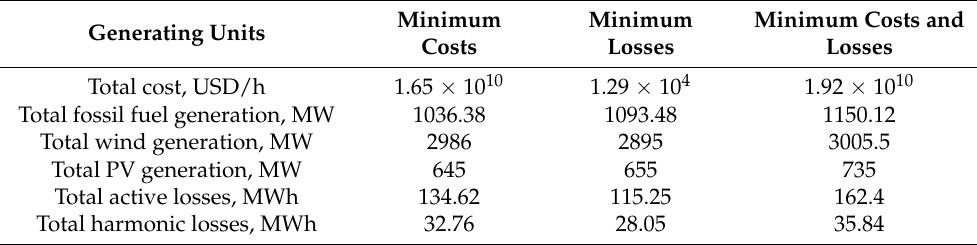
Table 9. Summary of the costs, generation, and losses for the three scenarios for Nigeria